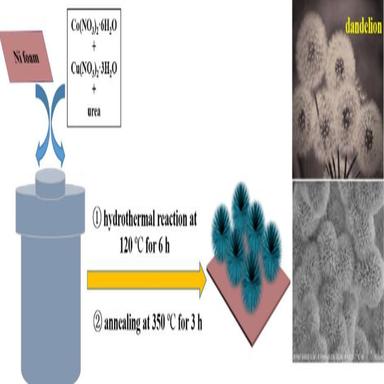
(A) XRD pattern and (B–D) SEM images of CuCo2O4 dandelion.